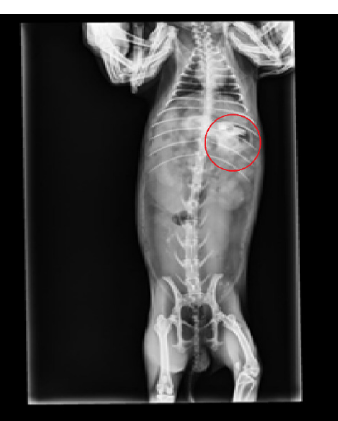
Figure 8(F) - X-ray image of Rabbit at 5h.